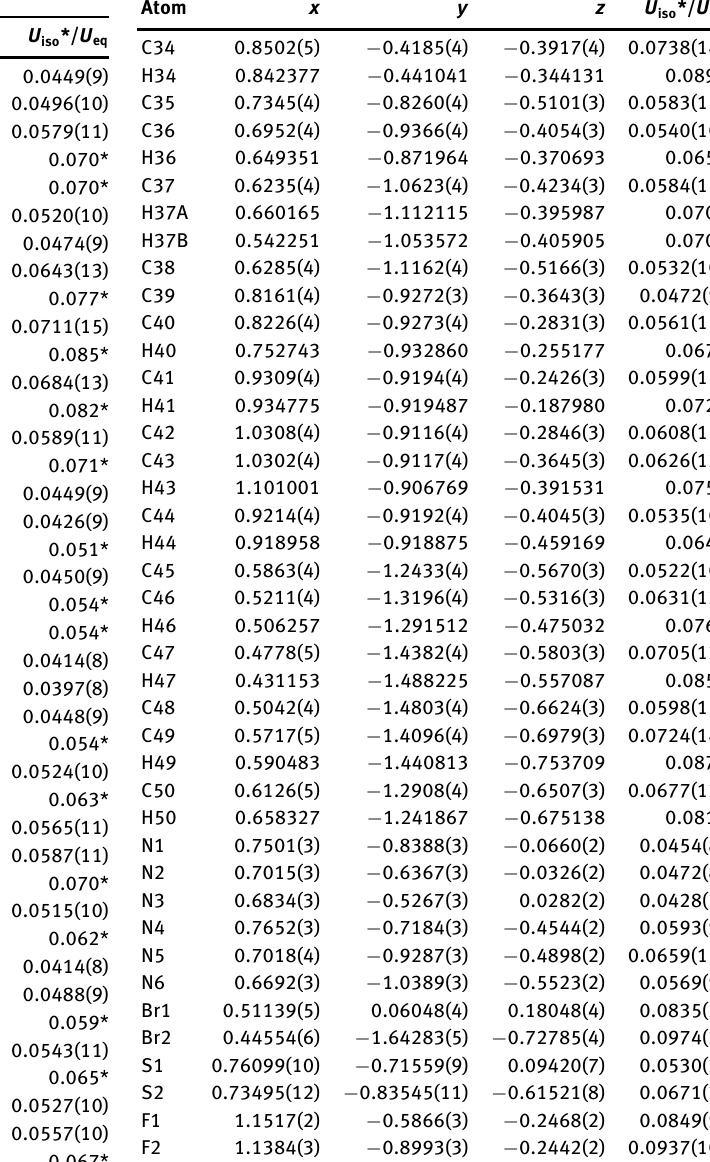
Table 2: Fractional atomic coordinates and isotropic or equivalent isotropic displacement parameters (Å 2